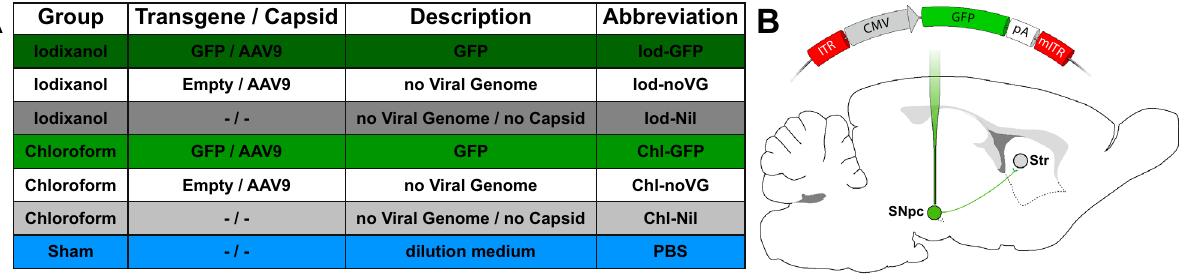
Figure 1. Experimental outline: ( A ) Description of the seven experimental groups. ( B ) Schematic of the self-complimentary (sc) viral genome expressing GFP under the CMV promoter injected into the midbrain of rats. GFP green fluorescent protein, Iod iodixanol, Chl chloroform, SNpc Substantia nigra pars compacta, Str striatum, ITR inverted terminal repeat, CMV cytomegalovirus promoter, pA polyadenylation